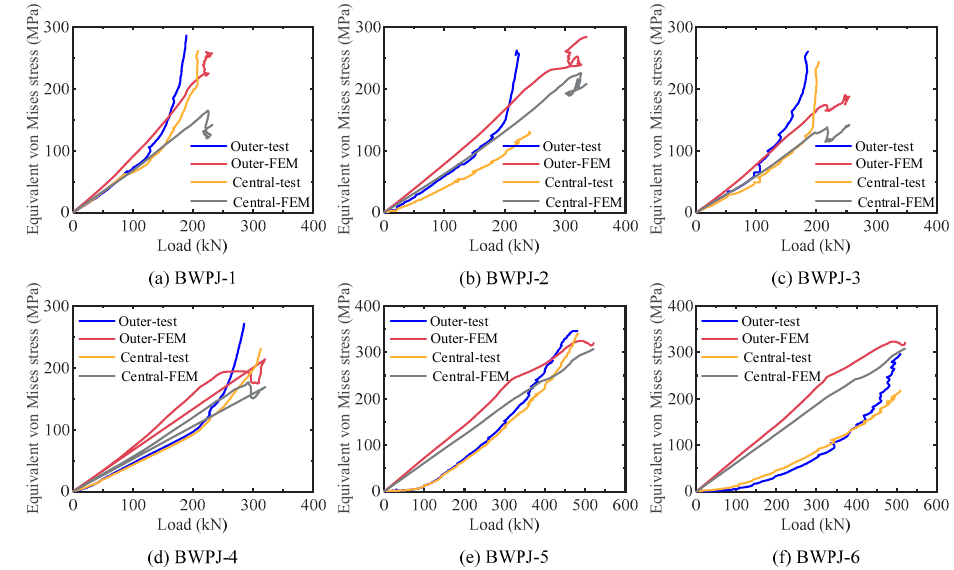
Figure 11. Stress development curves of the flange plate of the T ‐ stub connector.